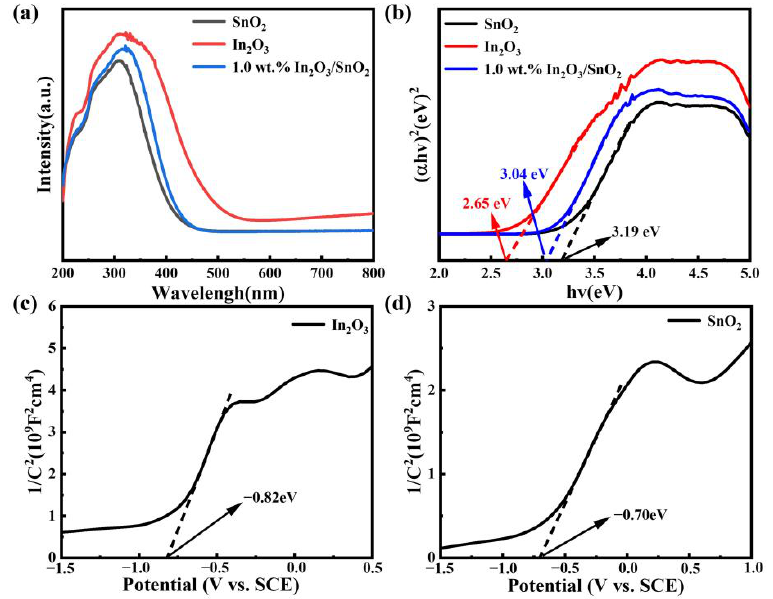
Figure 5. The optical performance of catalytic: ( a ) UV–Vis DRS; ( b ) The bandgap; The Mott–Schottky plot; ( c ) In 2 O 3 ; and ( d ) SnO 2 .